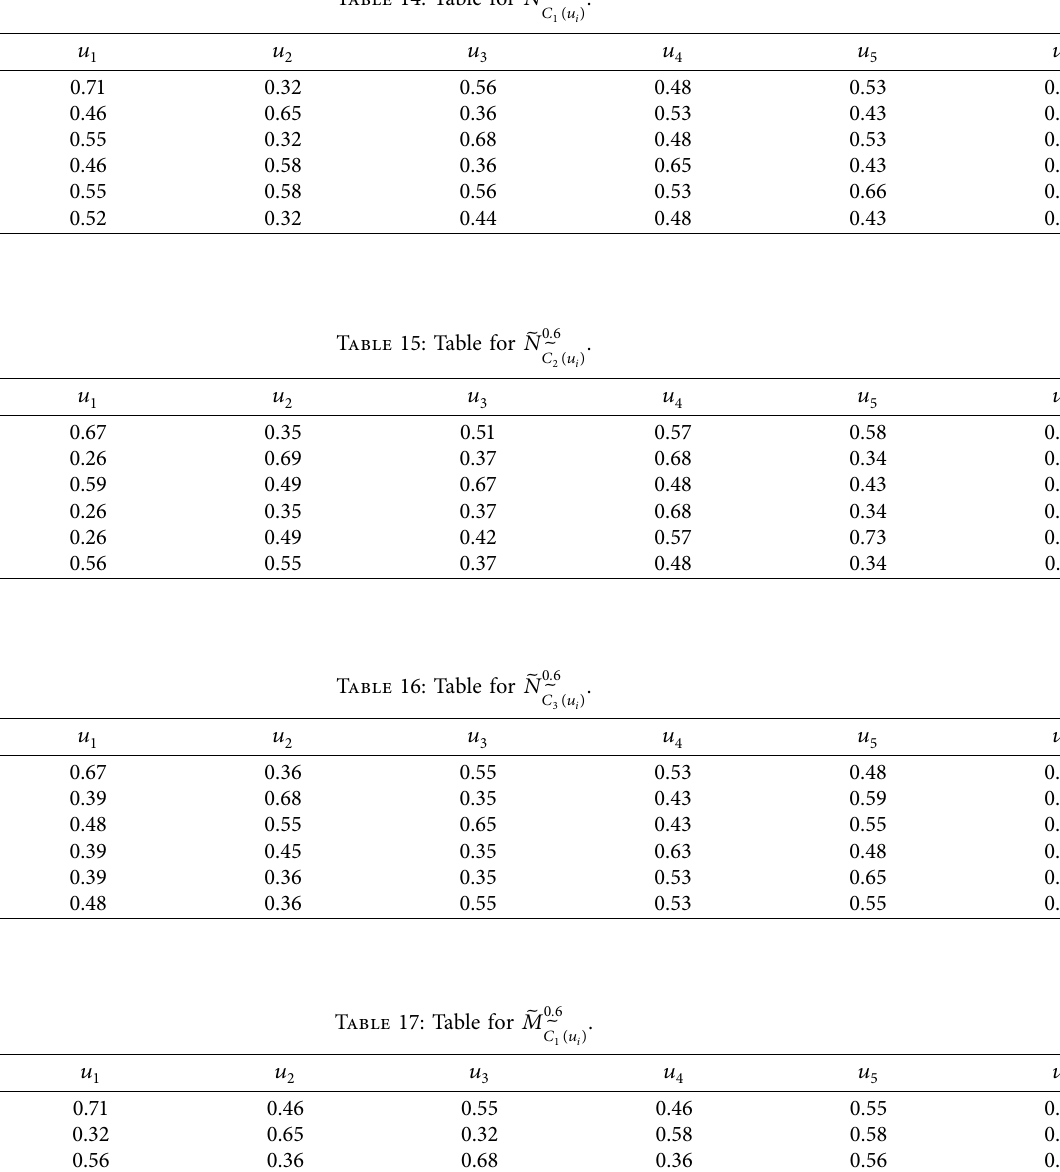
Table 14: Table for 􏽥 N 0 . 6 􏽥